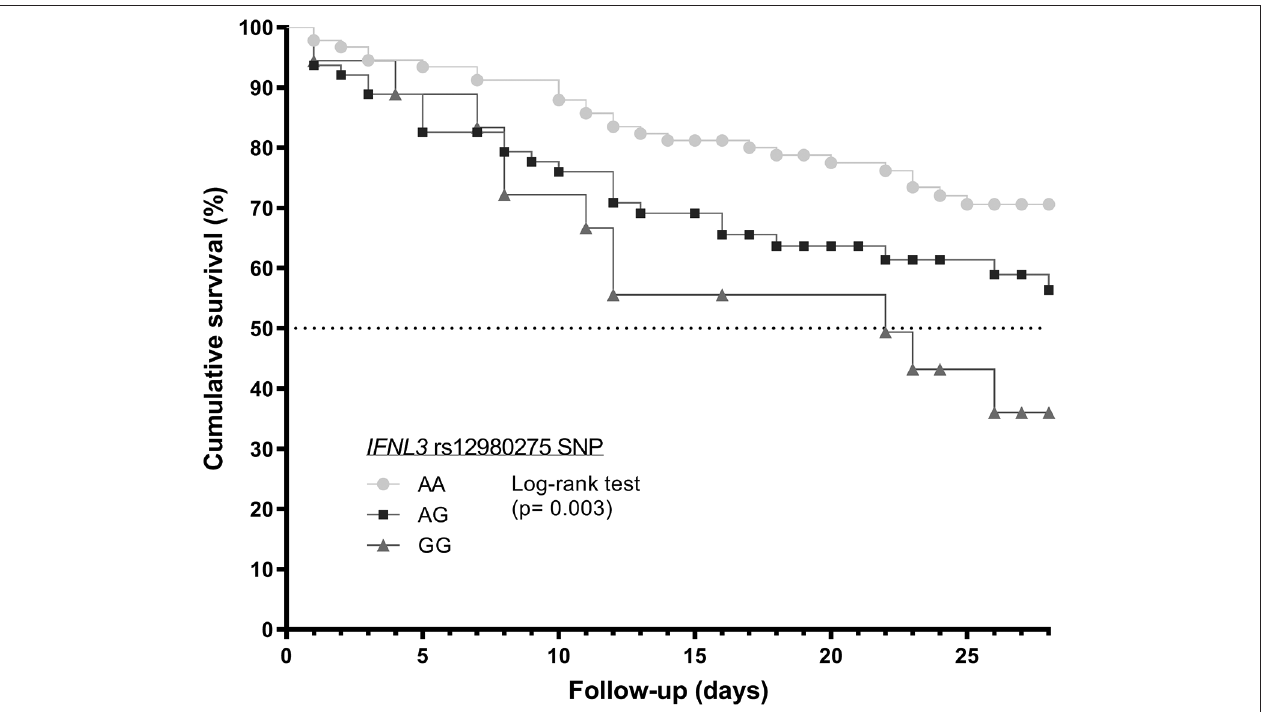
FIGURE 2 | Survival analysis (Kaplan–Meier curve) regarding to IFNL3 rs12980275 polymorphism in septic shock patients who underwent major cardiac or abdominal surgery. Statistics: P -value was calculated by log-rank test. Abbreviations: IFNL3, Interferon lambda 3; SNP, single nucleotide polymorphism.